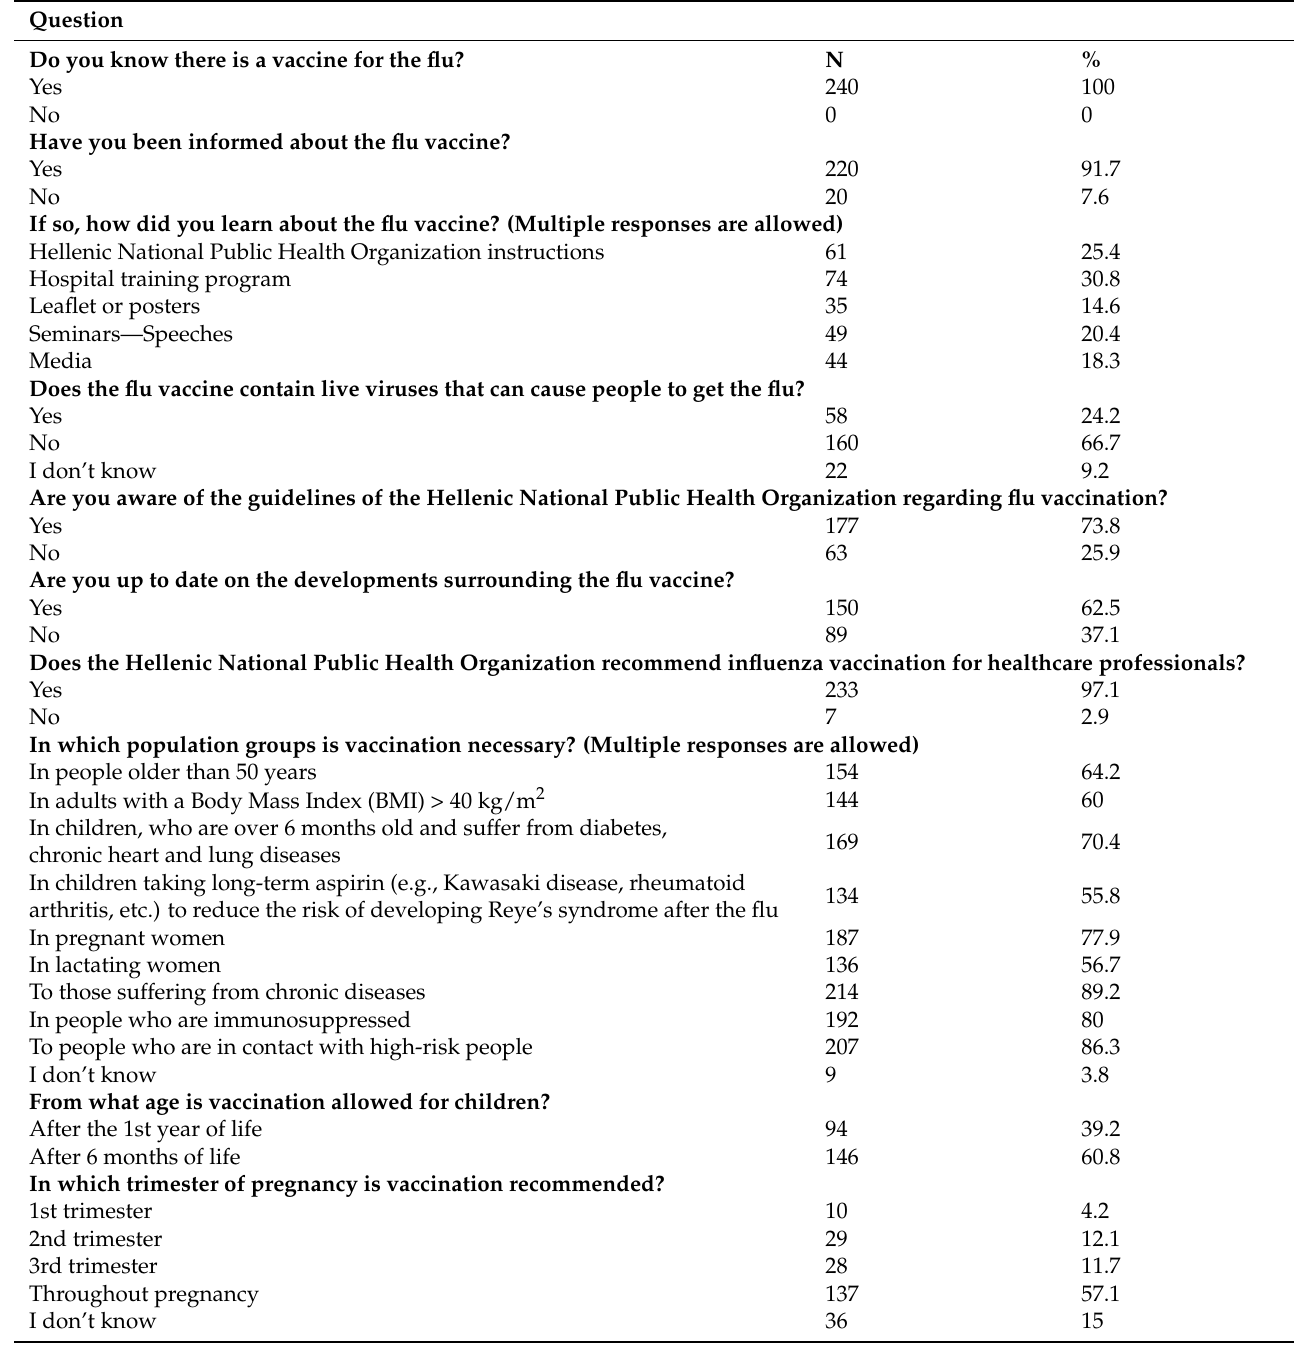
Table 3. Health professionals’ knowledge of the influenza